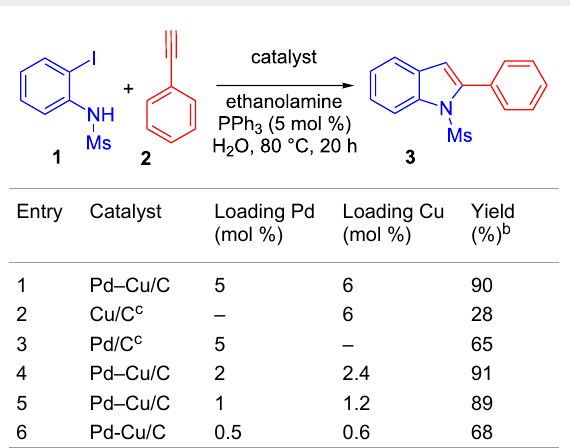
Table 1: Optimization of the catalyst loading.